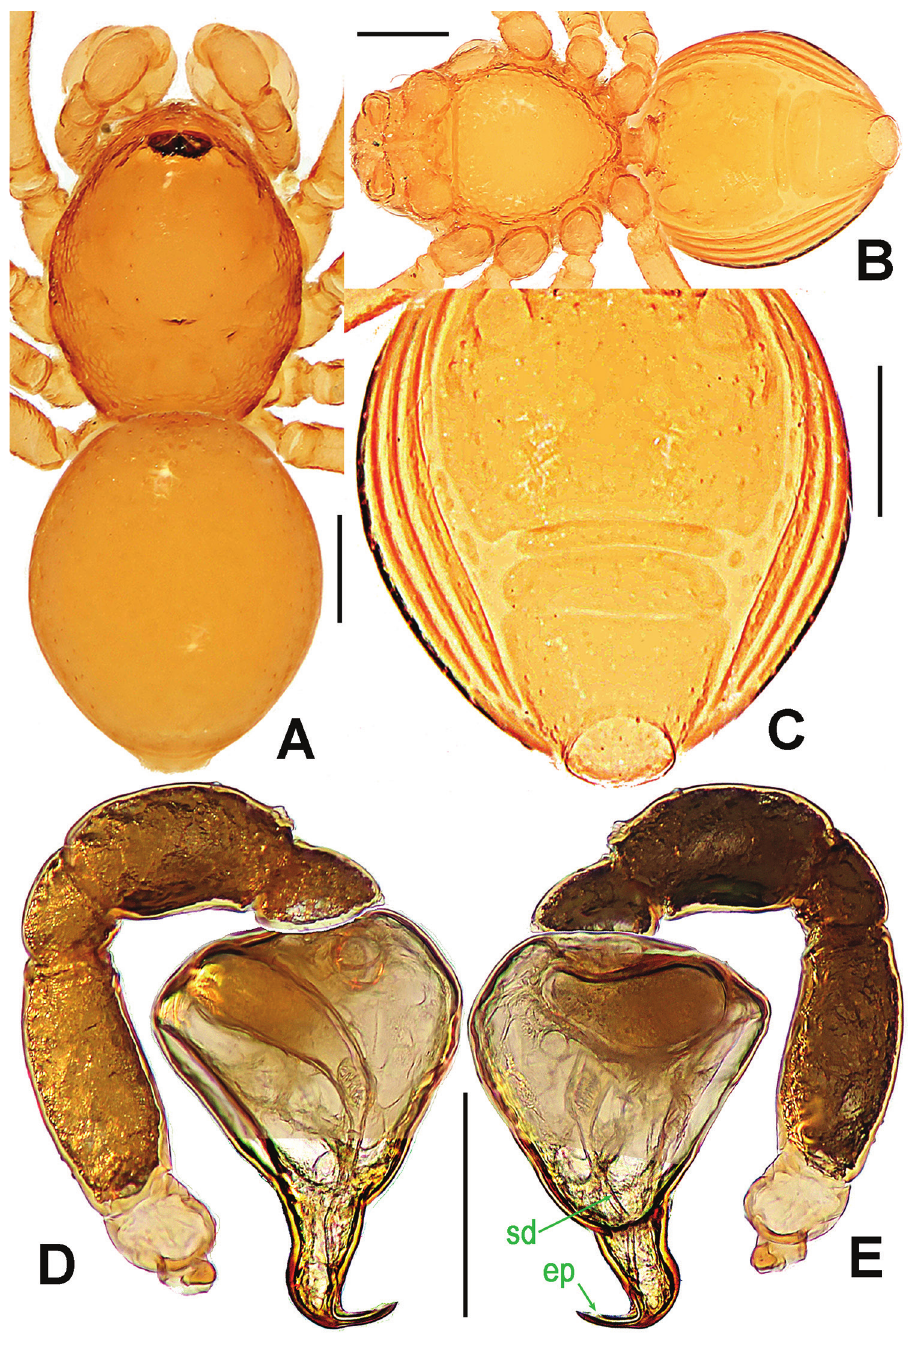
Figure 28. Sulaimania vigelandi Lehtinen, 1981, male paratype. A–B habitus C opisthosoma D–E left palp. A do rsal B–C ventral D prolateral E retrolateral. Abbreviations: ep = embolic part of apes of palpal organ; sd = spermatic duct. Scale bars: 0.10